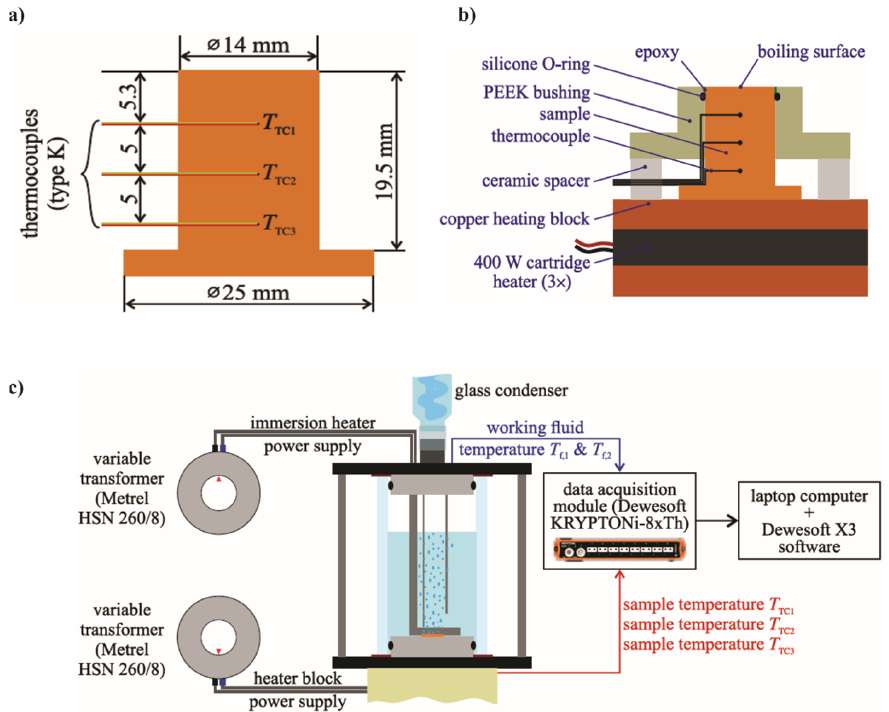
Figure 2. Dimensions of the sample including the position of thermocouples ( a ), cross section of the sample and the heating assembly ( b ), and experimental setup ( c ) .